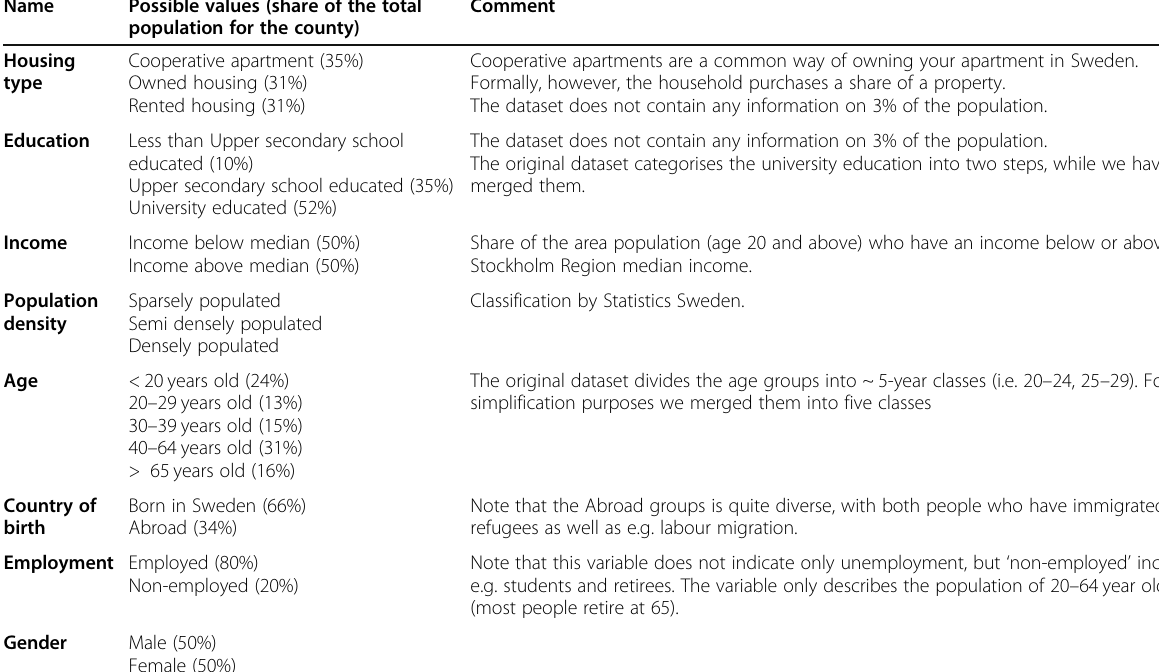
Table 1 Description of socioeconomic data (further details are available at ([31], in